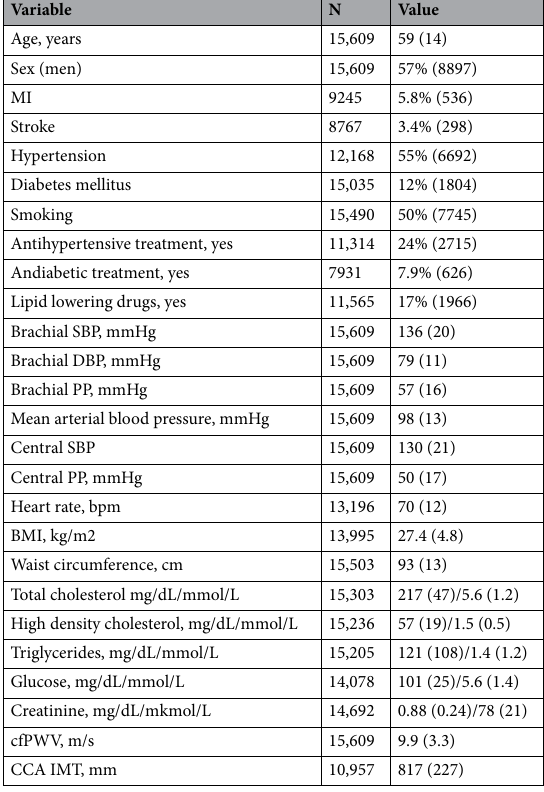
Table 1. Characteristics of the study cohorts from the MARE Consortium. Data are presented as the average (SD) for continuous measures and percentage (n) for categorical measures. Abbreviations: BMI, body mass index; MI, myocardial infarction; SBP, systolic blood pressure; DBP, diastolic blood pressure; PP, pulse pressure; CCA IMT, common carotid artery intima-media thickness; cfPWV, carotid-femoral pulse wave